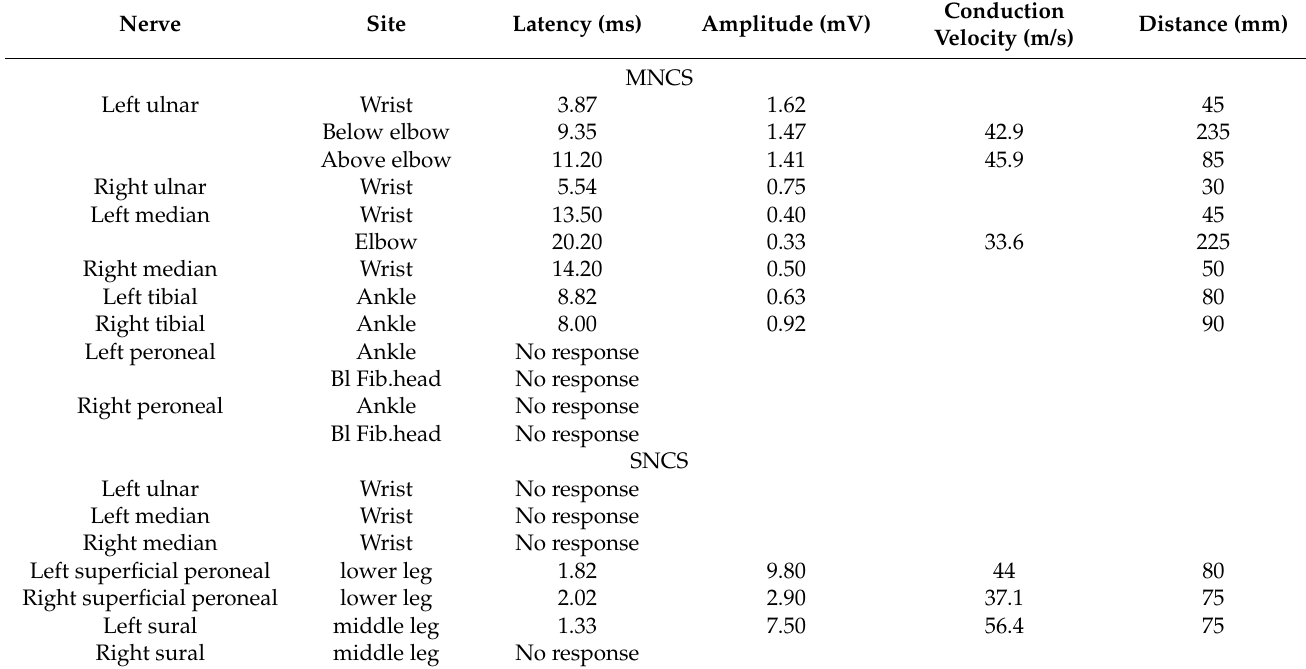
Table 1. The result of electromyography examination.